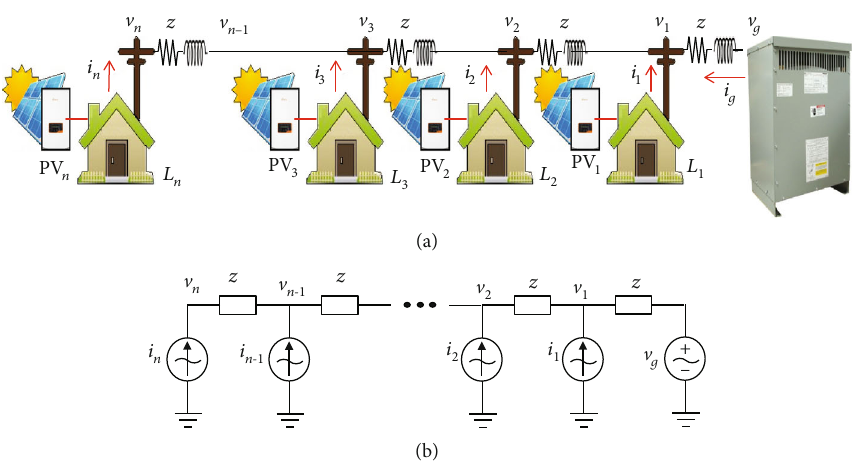
Figure 1: Analyzed system: (a) residential area with axial connection; (b) simpli fi ed